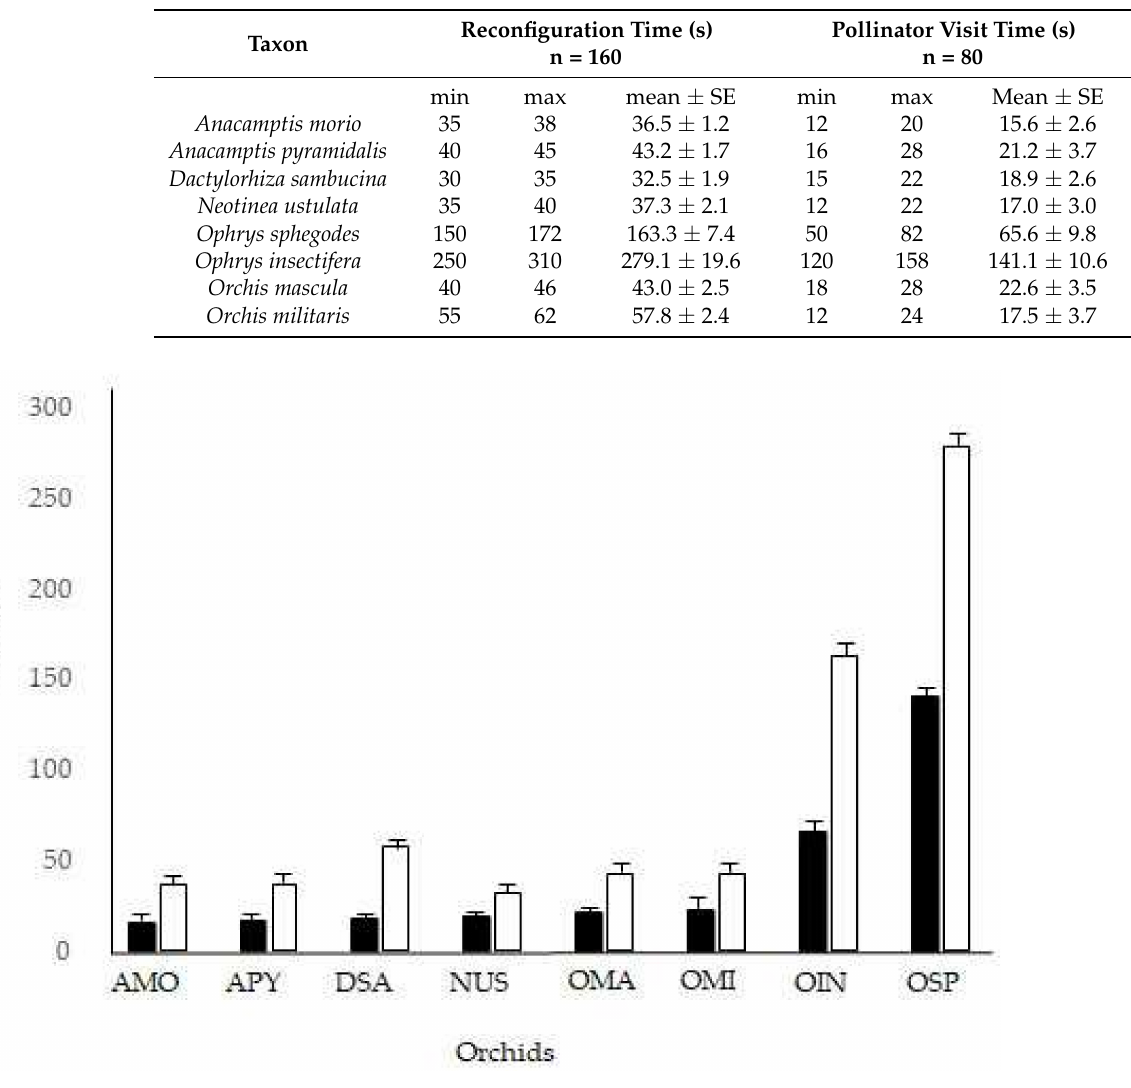
Table 1. Reconfiguration times for orchid pollinaria and the pollinator residency time on orchid inflorescence under field conditions (air temperature between 30–35 ◦ C). n = sample size.